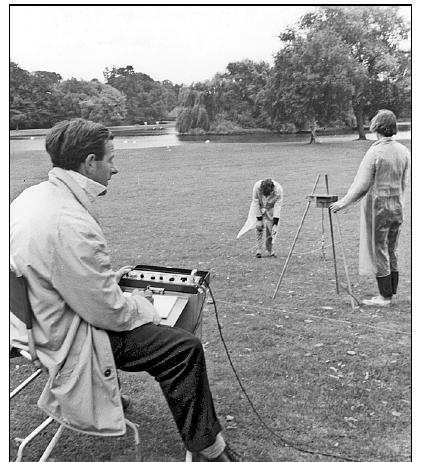
Figure 8 Martin Aitken using his proton magnetometer at Verulamium in 1959 to locate the “1955 Ditch” below the